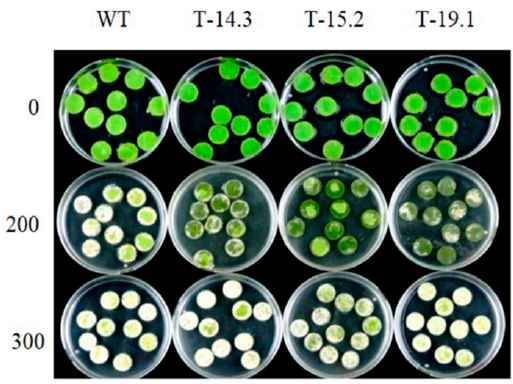
Figure 14. Leaf disc senescence assay under salt stress. Leaf discs from fully expanded leaves of two- month-old WT and AnnAt8 transgenic tobacco plants were floated on NaCl solution for the stress treatment. The treatments were carried out in continuous light until identifiable differences were observed. Leaf discs of the WT plants bleached out faster in the stress medium (0, 200, 300 mM NaCl). However, the chlorophyll loss was slow in the transgenic lines. Three replicates were used per treatment, and the experiment was repeated at least three times and similar findings were observed.